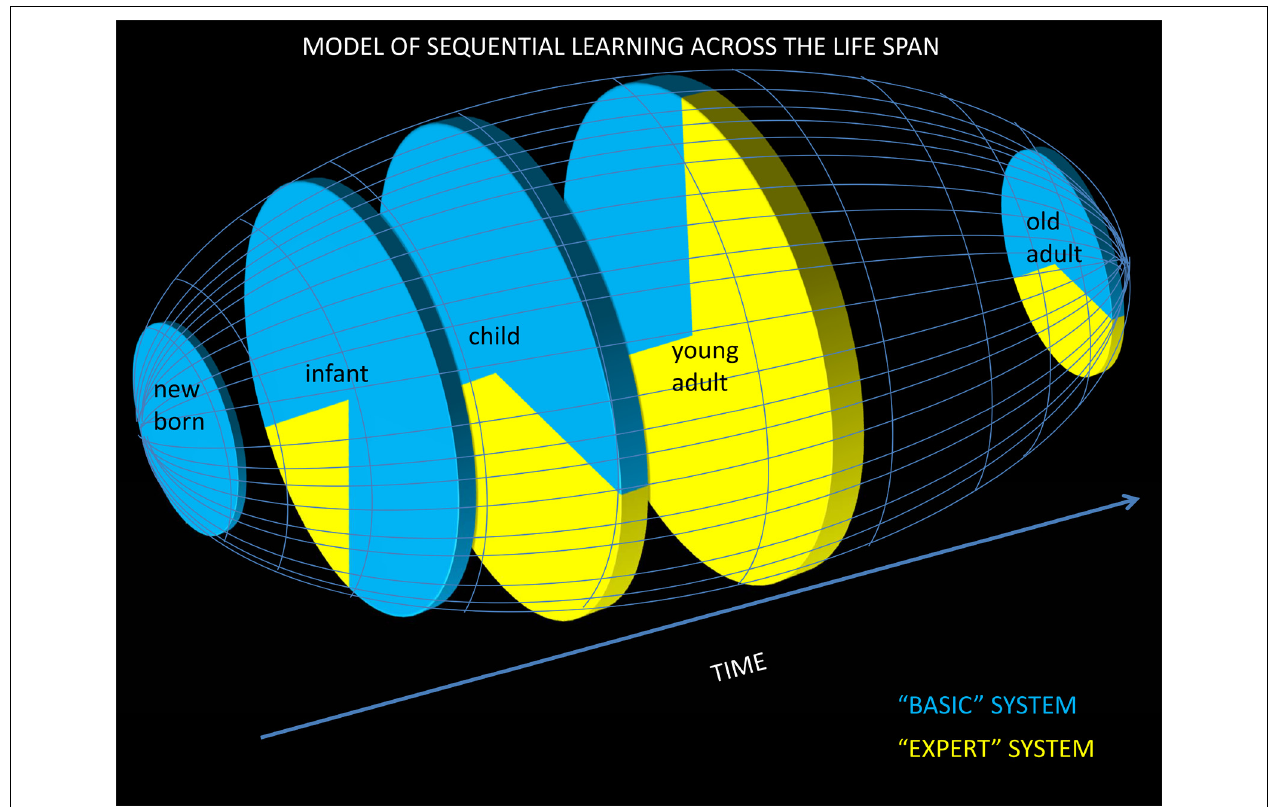
top-down explicit multimodal and retrospective mechanisms, depends on the level of intention (to learn) and attention (including selective attention through social cues).The “expert” system, which captures more abstract patterns, increasingly develops from childhood into adulthood and then declines in old age because of impaired working and sensory memories. Blue represents the proportion of SL governed by the basic system and yellow represents the proportion of SL governed by the expert system. Clearly, this model is tentative and highly speculative. In particular, the exact degree of contribution of the basic and expert systems at different ages of life remain currently